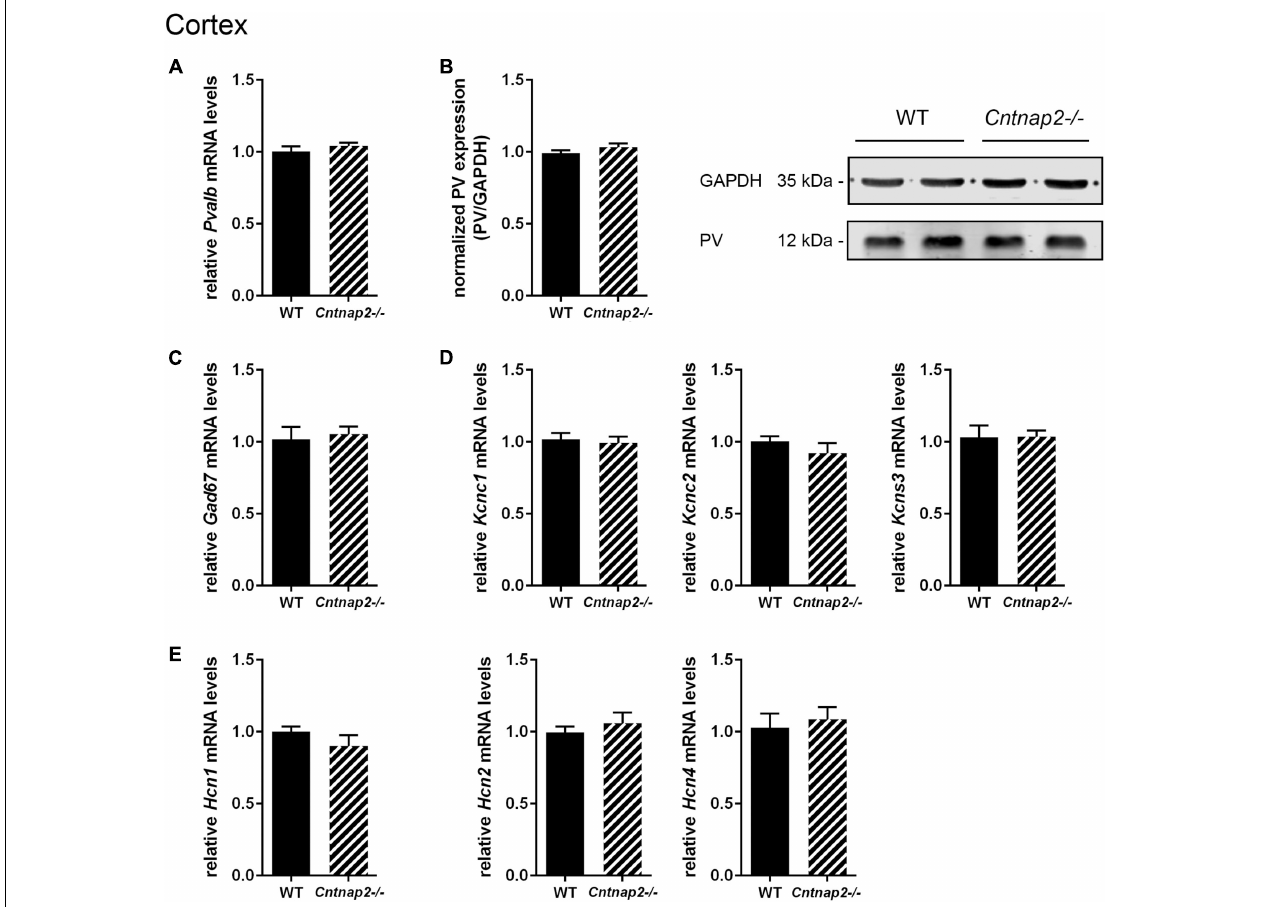
FIGURE 5 | RT-qPCR values from cortical samples of PND25 mice representing mRNA levels for (A) Pvalb , (C) Gad67 , (D) Left: Kcnc1 ; Middle: Kcnc2 ; Right: Kcns3 , (E) Left: Hcn1 ; Middle: Hcn2 ; Right: Hcn4 . Signals were normalized to Rn18S mRNA levels and expressed as fold change compared to WT ( N = 6 mice each). (B) Left: Quantitative Western blot analysis of cortical samples of PND25 WT and Cntnap2–/– mice ( N = 6 mice each). Quantification of PV protein levels in the cortex is shown. GAPDH signals served as loading controls and were used for the normalization of PV protein signals. Results are expressed as a percentage of normalized PV/GAPDH signals in the WT group. Right: Representative Western blot signals for PV and GAPDH are shown. All data are expressed as mean ±